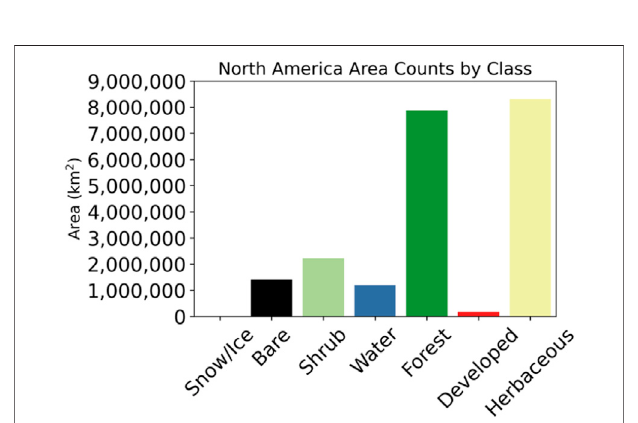
FIGURE 5 | Area occupied by each class in GLanCE Level 1 legend for North America (excluding Greenland).